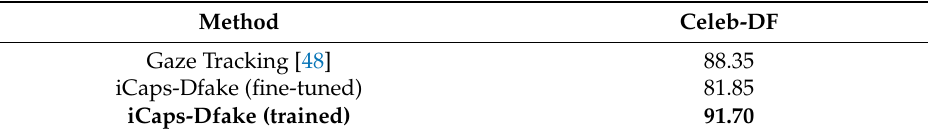
Table 7. Video-level Accuracy (%) on Celeb-DF dataset.